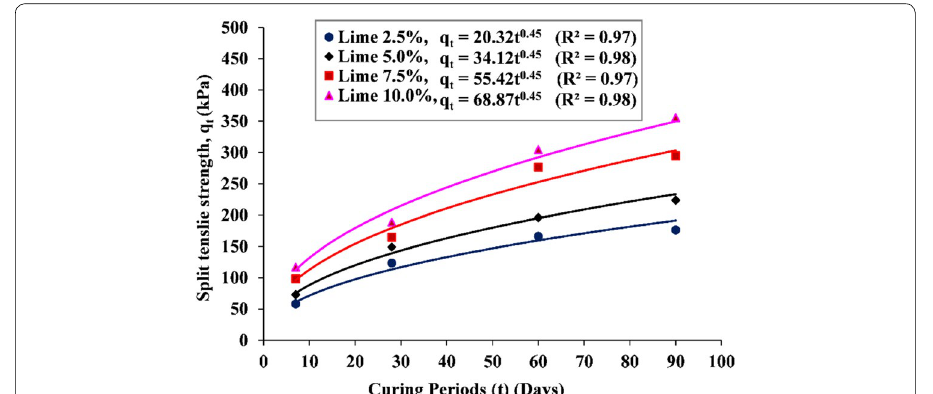
Fig. 7 Effect of lime content on split tensile strength (q t ) with curing periods